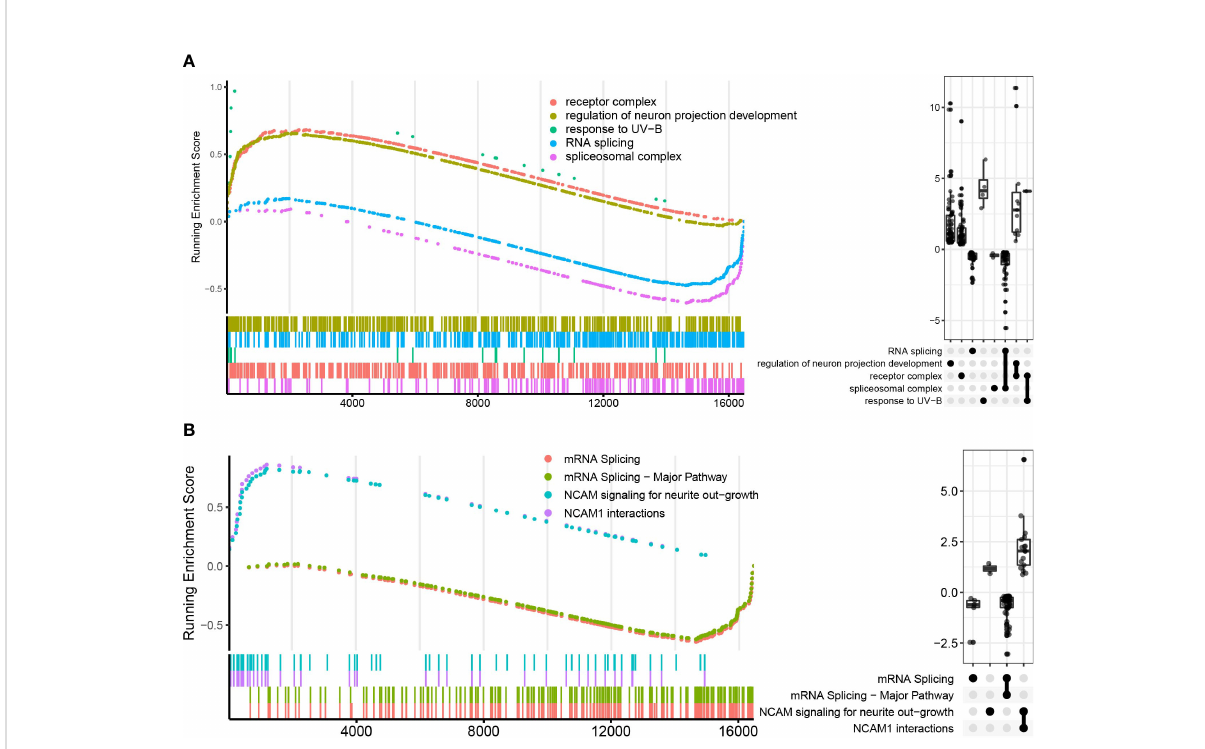
FIGURE 4 GO and Reactome pathways enrichment analysis in LTBI vs. HC in GSEA enrichment plot. (A) shows the top fi ve pathways in GO enrichment analysis, (B) shows the top four pathways in Reactome enrichment analysis. The upper curves represent the running sum of enrichment scores, the bottom part of the fi gure shows the position of genes that are related to certain pathways. The Upset plot on the right visualizes the metric distribution of genes belonging to a pathway or multiple